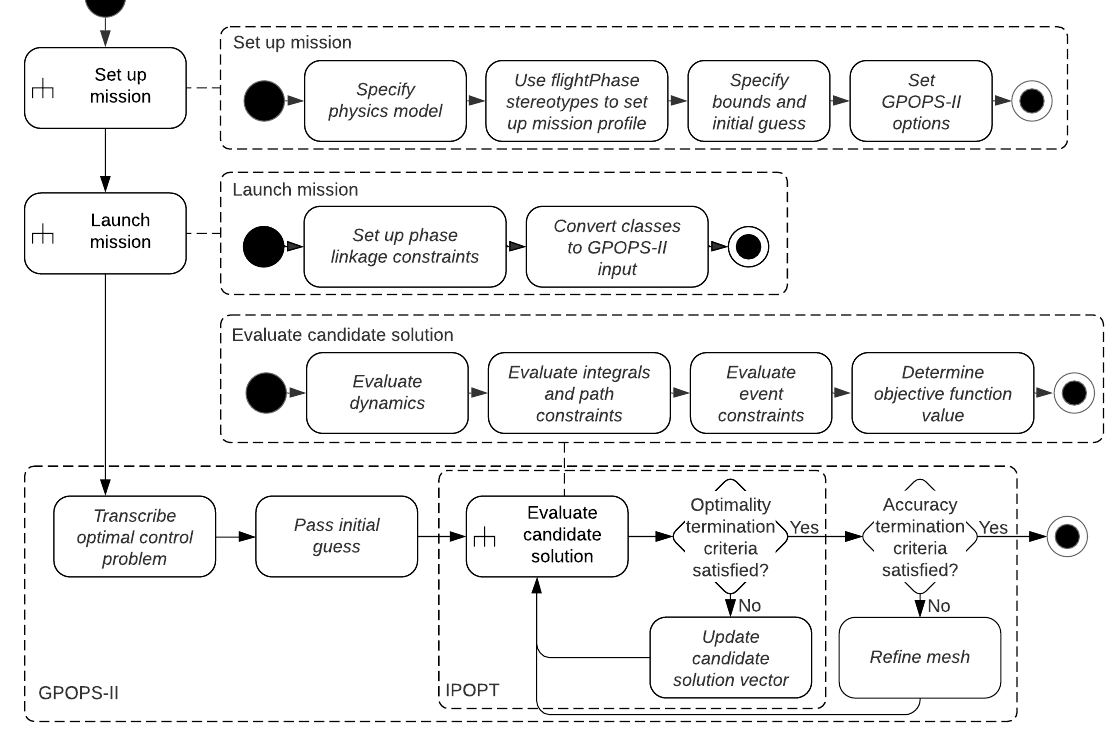
Figure 5. A UML activity diagram of the trajectory optimization program in PHALANX.